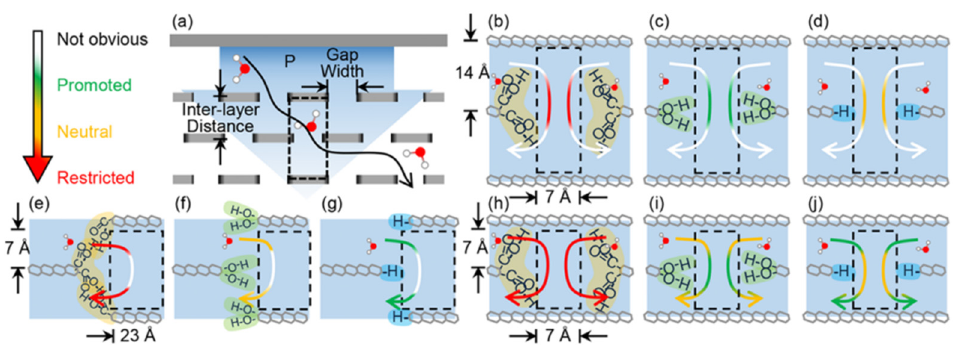
Figure 15. Summary of the individual influences of the three kinds of edge functional groups on water transport under different geometric membrane structures. ( a ) Illustration of the membrane system. Geometric structures of the membranes are ( b – d ) 7 × 14, ( e – g ) 23 × 7, and ( h – j ) 7 × 7, and their edge functional groups are ( b , e , h ) –COOH, ( c , f , i ) –OH, and ( d , g , j ) –H. Green, orange, red, and white parts of the arrows illustrate the promoted, neutral, restricted, and not obvious influences from the edge functional groups, respectively [138]. Reprinted with permission from {Qiu, R.; Yuan, S.; Xiao, J.; Chen, X.D.; Selomulya, C.; Zhang, X.; Woo, M.W. Effects of Edge Functional Groups on Water Transport in Graphene Oxide Membranes. ACS Appl. Mater. Interfaces 2019 , 11,